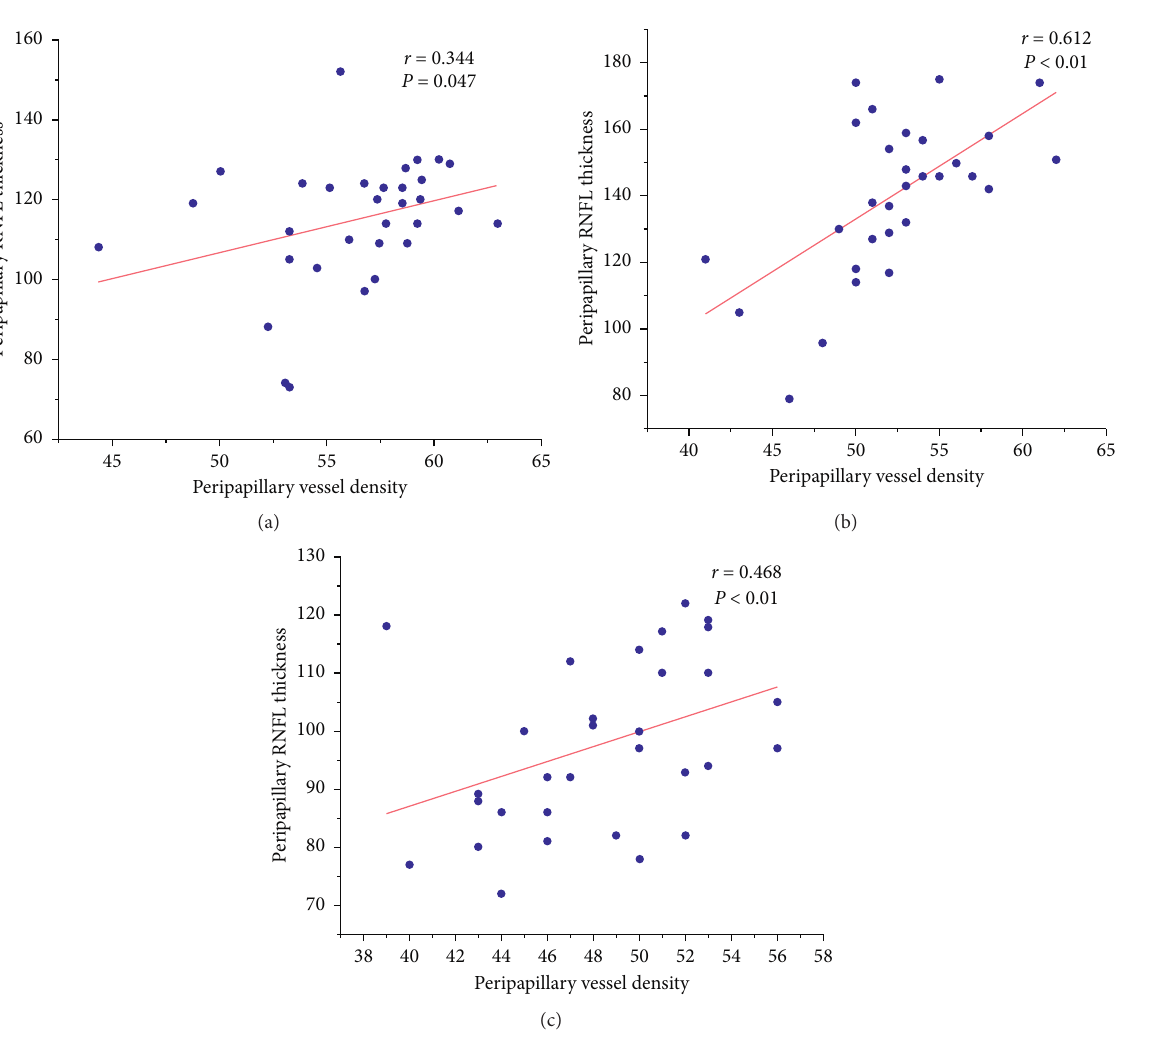
Figure 3: Scatter plots of RNFL thickness and peripapillary vessel density in the preclinical group. (a) Scatter plot of average RNFL thickness and vessel density. (b) Scatter plot of superior RNFL thickness and vessel density. (c) Scatter plot of temporal RNFL thickness and vessel